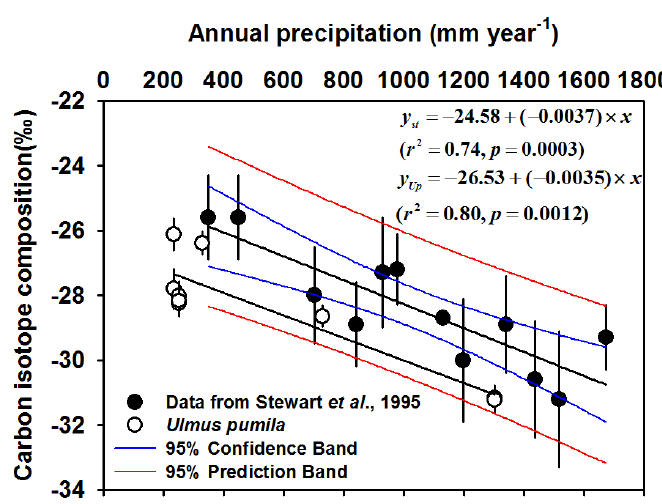
Figure 7. Carbon isotope composition (‰, δ 13 C), adopted from Stewart et al. [18], and Siberian elm leaf samples. y St denotes regression data from Stewart et al. [18] and y Up denotes regression of δ 13 C in Siberian elm versus annual precipitation (mm).